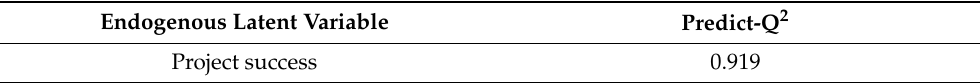
Table 12. Predictive relevance.